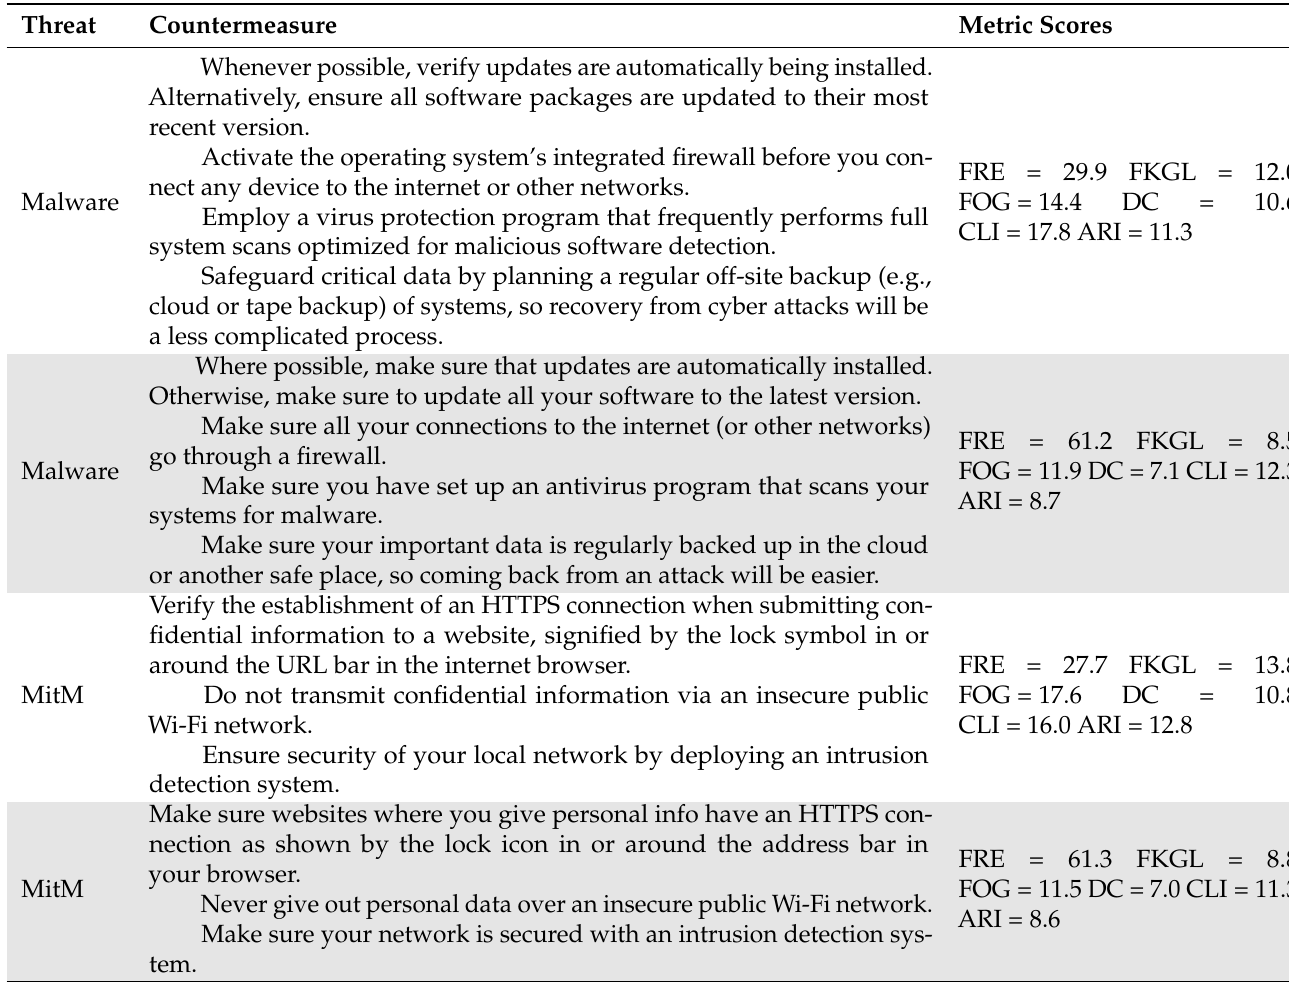
Table 5. Example countermeasure readability improvements. The gray rows contain the more readable countermeasures. Threat Countermeasure Metric Scores